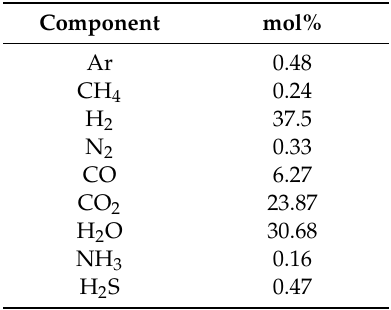
Table 1. Composition of the analyzed flue gas